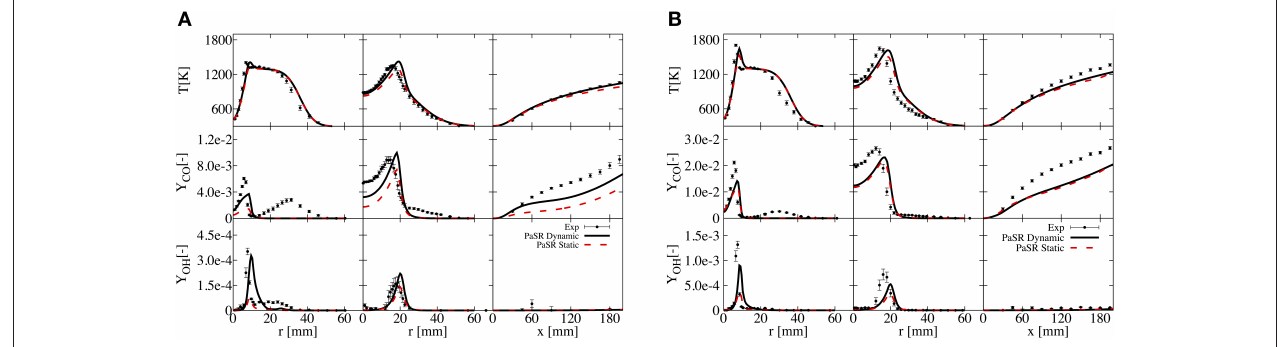
FIGURE 2 | Comparison of T , OH , and CO for static and dynamic PaSR with experimental data at axial locations of 30 and 120 mm and along the axis for HM1 (A) and HM3 (B)